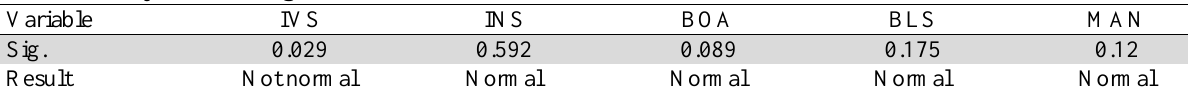
The summary of Kolmogorov-Smirnov test Variable IVS INS BOA BLS MAN Sig. 0.029 0.592 0.089 0.175 0.12 Result Not normal Normal Normal Normal